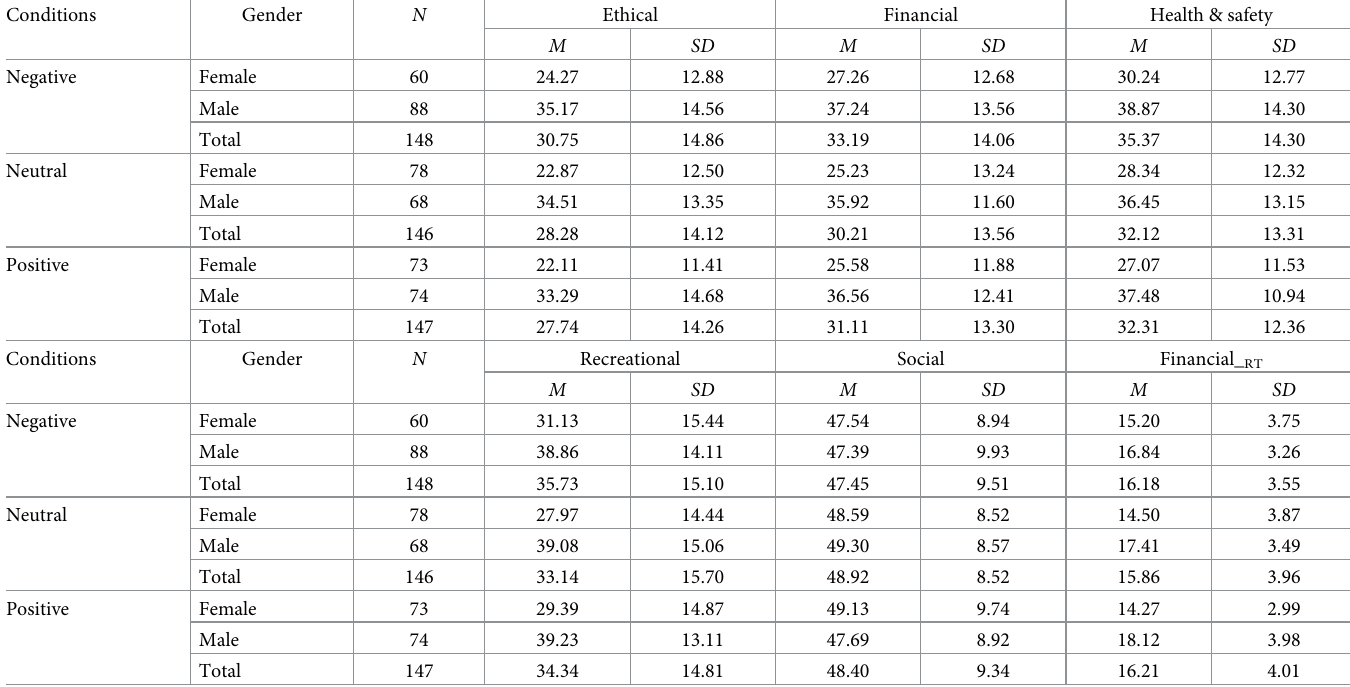
Table 2. Descriptive analysis for risk taking in different domains in Study